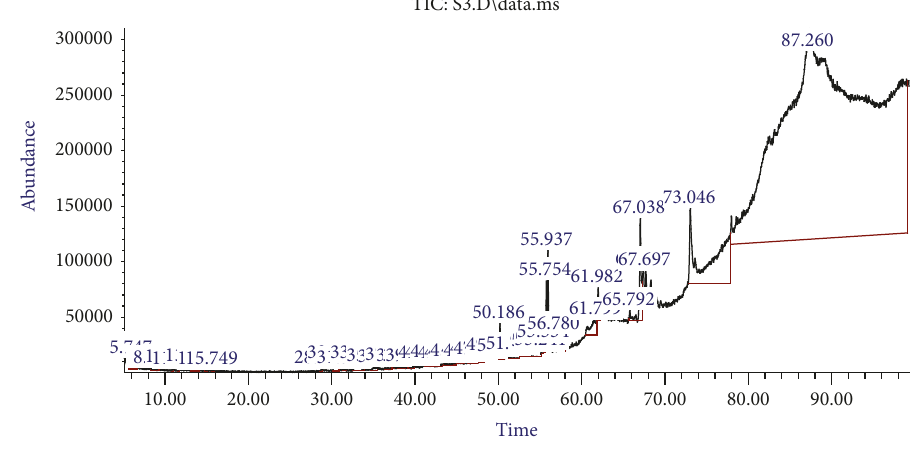
Figure 5: Infrared spectrum of SFAEPAS-3. Table 2: Possible components of SFAEPAS-3 from GC-MS analysis and suggested names from NIST (2004) library.